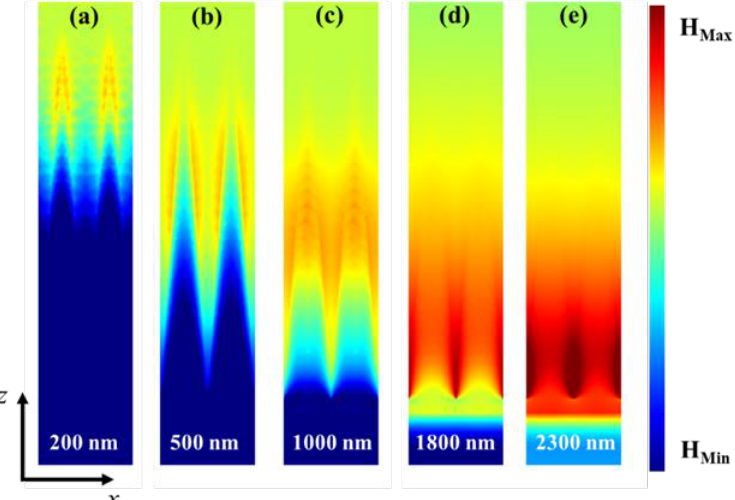
Figure 5. Magnetic field distributions at the different wavelengths of 200 nm ( a ), 500 nm ( b ), 1000 nm ( c ), 1800 nm ( d ), and 2300 nm ( e ) in the x-z plane.